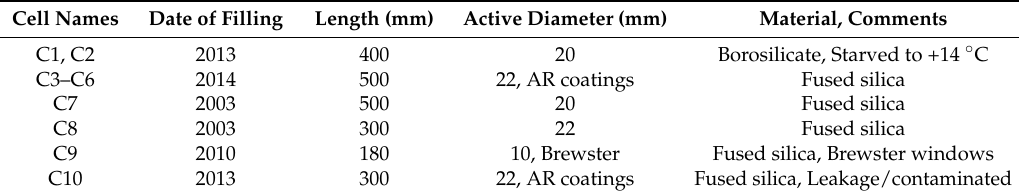
Table 1. Description of tested iodine absorption